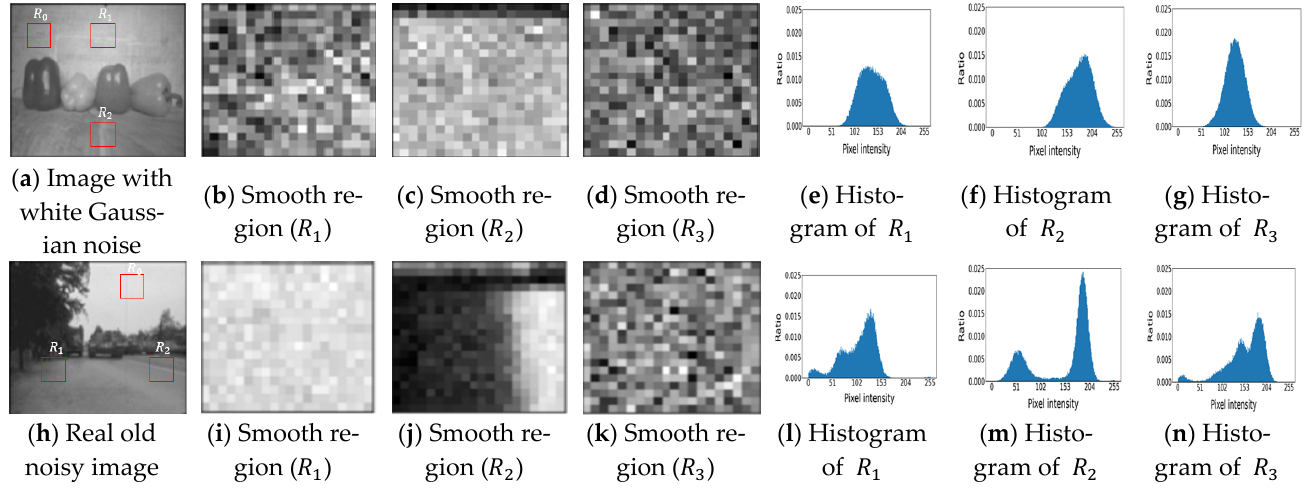
Figure 1. Histogram comparison between the smooth regions of AWGN added in a clean image and realistic old ‐ image noise.